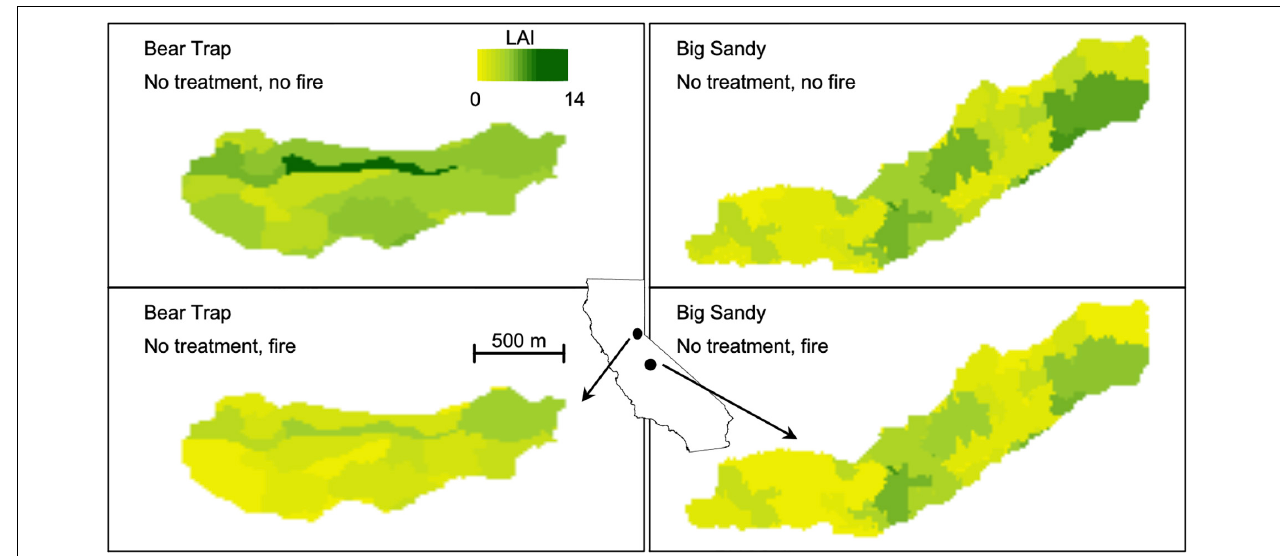
FIGURE 1 | Leaf Area Index (LAI) values in the Bear Trap and Big Sandy catchments in the highest (no treatment, no fire) and lowest (no treatment, fire) vegetation density